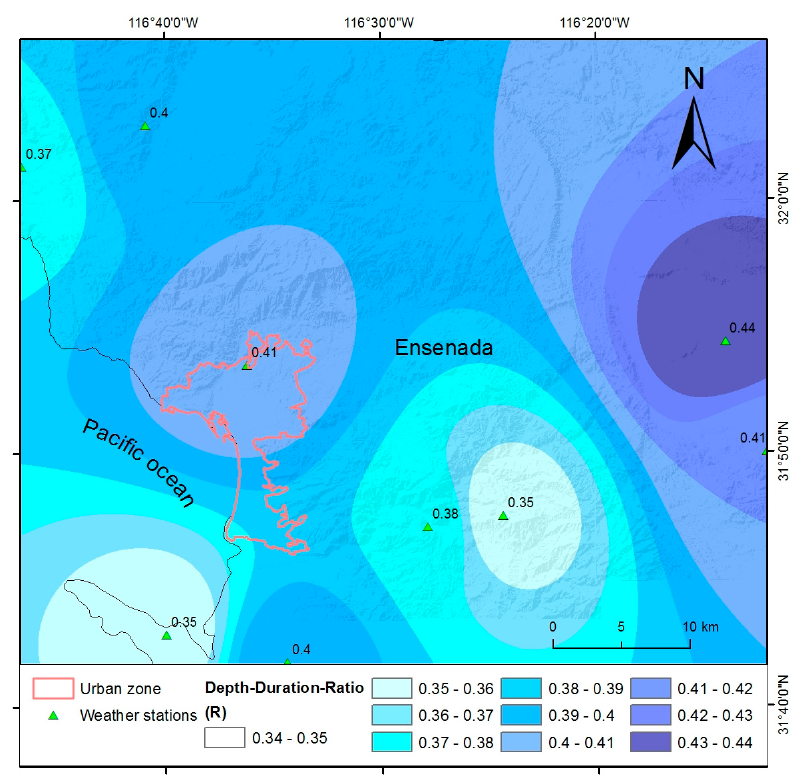
Figure 5. Distribution of the Depth-Duration Ratio ( R ) for the city of Ensenada.